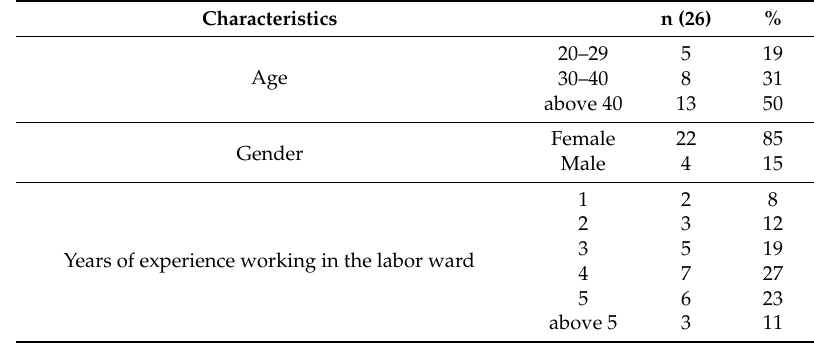
Table 3. Demographic description of participants by age group, gender and number of years of